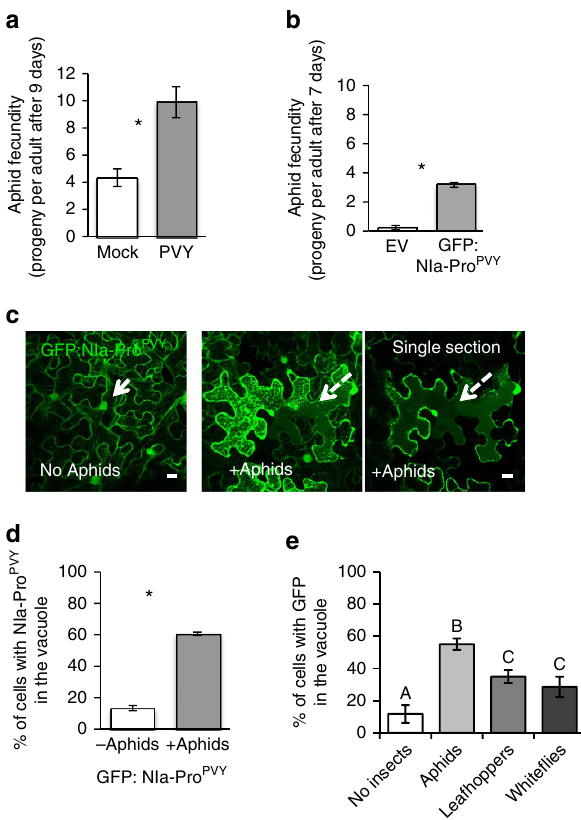
Figure 6 | The function of NIa-Pro in virus–plant–aphid interactions is conserved. ( a ) The number of progeny produced by aphids on healthy (mock) or PVY-infected N. benthamiana . ( b ) The number of progeny produced by aphids on N. benthamiana agroinfiltrated with empty agrobacterium (EV) or expressing GFP:NIa-Pro from PVY. ( c ) Images show confocal projection and single section (on the right) of N. benthamiana leaves agroinfiltrated with GFP:NIa-Pro from PVYwith or without aphids for 24h. GFP:NIa-Pro relocalizes from the nucleus (white arrow) to the vacuole (dashed arrow) in the presence of aphids. ( d ) The percentage of cells with GFP in the vacuole for N. benthamiana expressing GFP:NIa-Pro from PVY with and without aphids. ( e ) The percentage of cells with GFP:NIa-Pro in the vacuole for each of the treatments: agroinfiltrated N. benthamiana with no insects, with aphids, with leafhoppers or with whiteflies for 24h. (mean ± s.e. of N ¼ 24–27 for a , N ¼ 6–9 for b , N ¼ 6 for d and N ¼ 3 for e ; stars and letters represent significant differences, Student’s t test, P o 0.05 for a – d , and ANOVA and Tukey’s honest significant difference post hoc for e , P o 0.05 ). Results from one out of two independent experiments are displayed in a , b , and from three independent experiments in d . Scale bars, 20 m